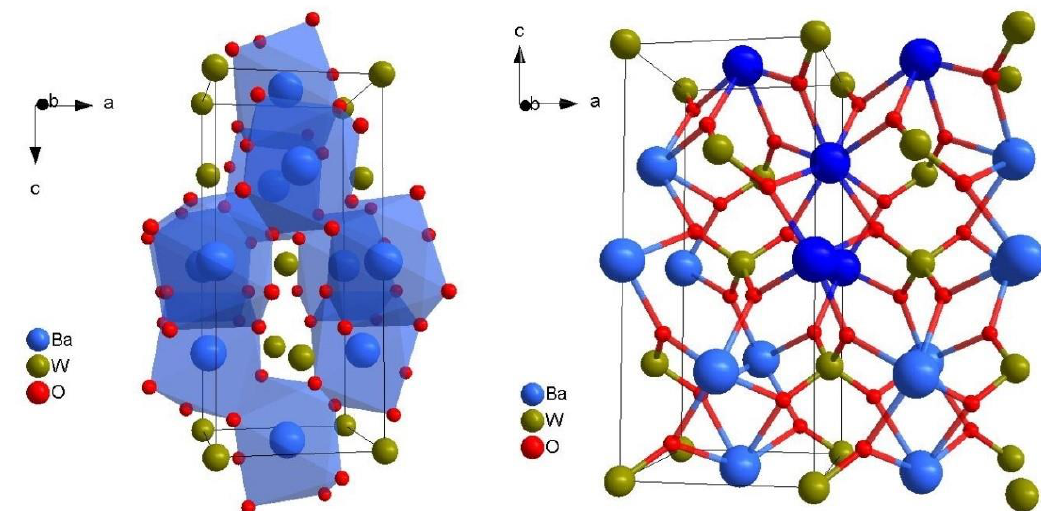
Figure 1. Unit cell structure of BaWO 4 single crystal: (1) left picture-unit cell with marked barium dodecahedrons [BaO 8 ] (2) right picture-double unit cell with marked Ba 2+ -Ba 2+ and Ba 2+ -W 6+ connections via oxygens bridges. The five Ba 2+ ions are highlighted in dark blue color.